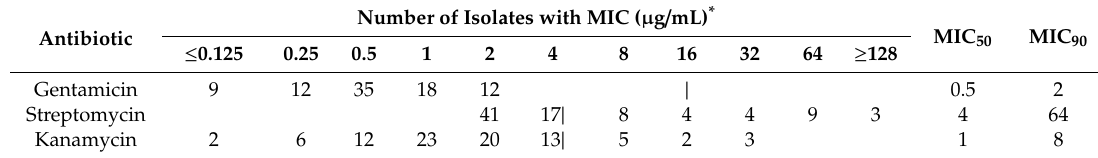
Table 1. Distribution of minimum inhibitory concentration (MIC), MIC 50, and MIC 90 values of three aminoglycoside antibiotics among studied Trueperella pyogenes isolates ( n = 86). Number of Isolates with MIC ( µ g / mL) * Antibiotic